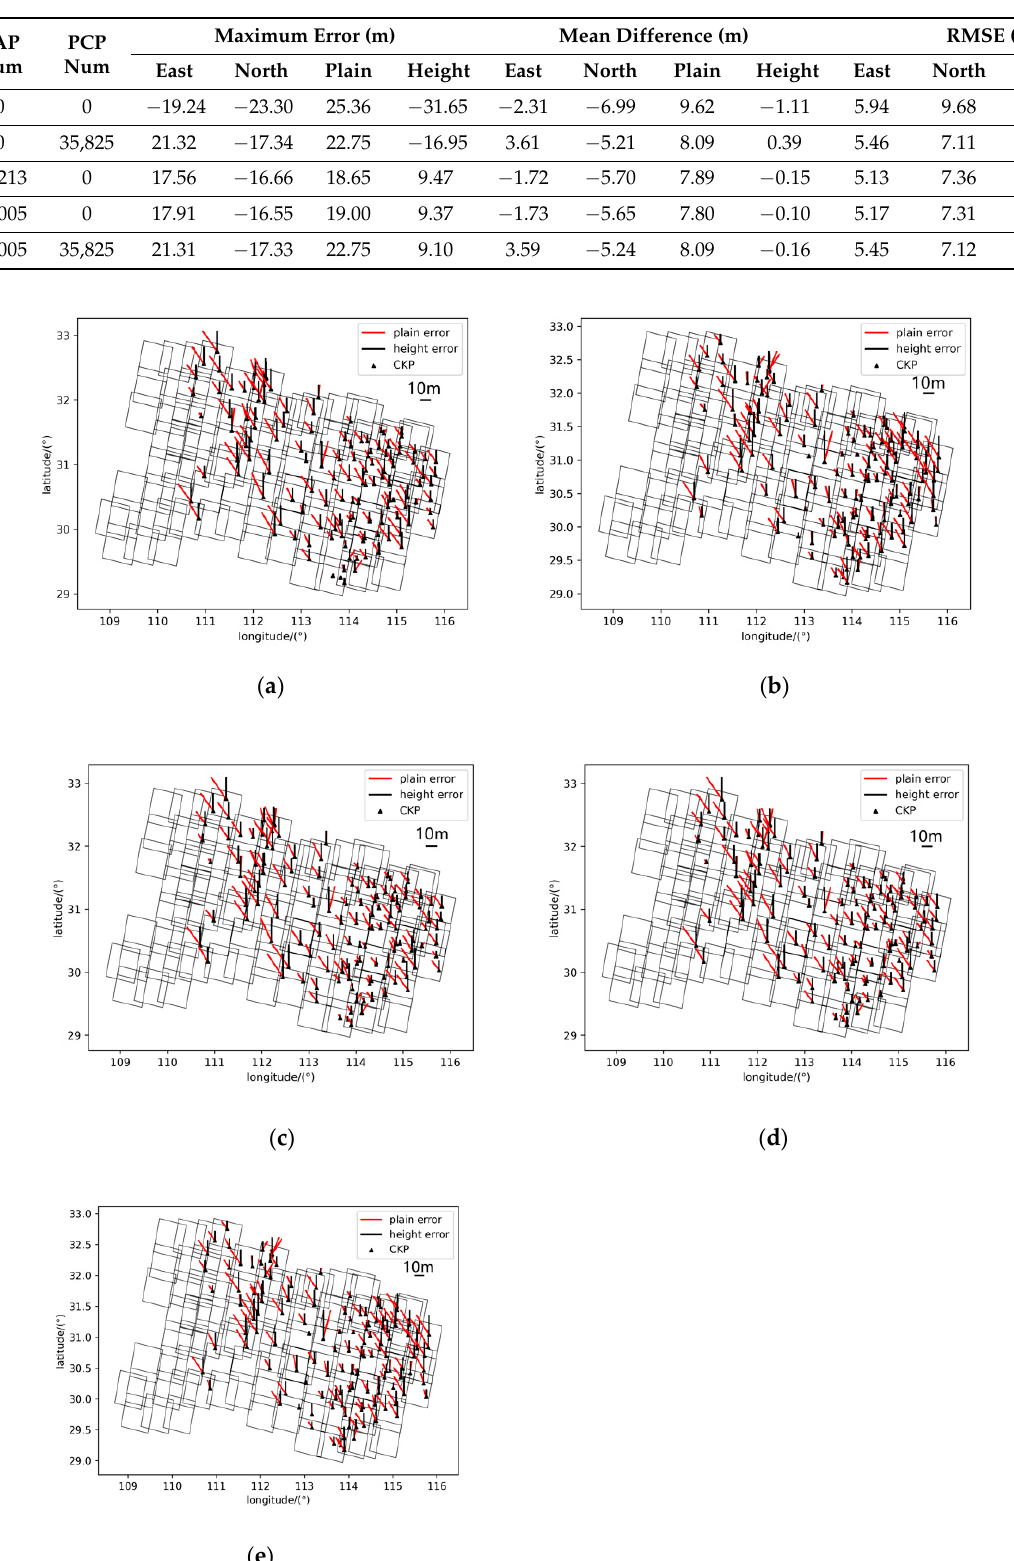
Figure 11. Mapping Satellite-1 block adjustment each plan residuals distribution. ( a ) plan a, ( b ) plan b, ( c ) plan c, ( d ) plan d and ( e ) plan e.